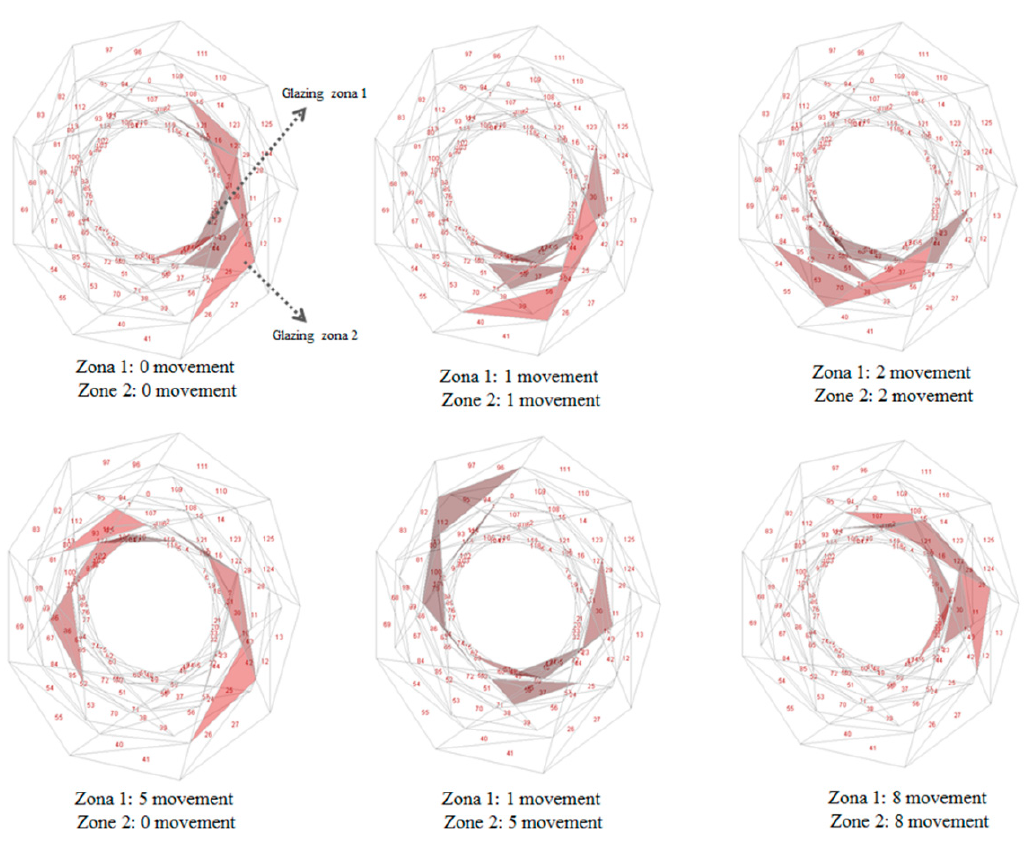
Figure 10. Samples of the glazing movement in Zone 1 and Zone Figure 10 . Samples of the glazing movement in Zone 1 and Zone 2 .